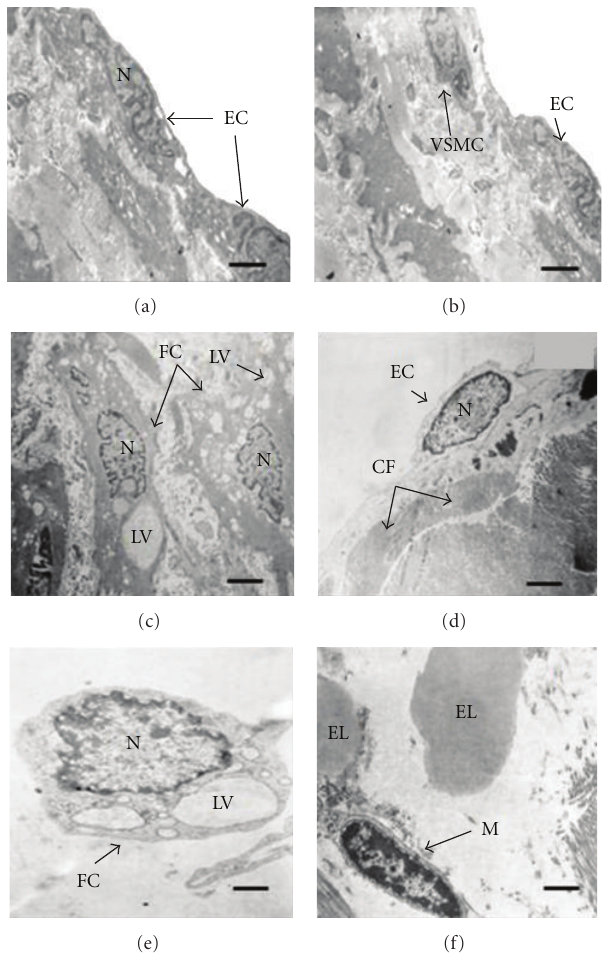
Figure 2: Ultrastructural analysis. Panels (a) and (b) correspond to animals of control group, while panels (b), (c), (d), and (e) show the e ff ects of Lipofundin administration on atherosclerotic lesion formation. EC: endothelial cells, EL: extracellular lipids, VSMC: vascular smooth muscle cells, N: nucleus, FC: foam cells, LV: lipid vacuolization, CF: collagen fibers, M: myofibroblasts. Scale bar 1 μ m (a, b, c, d), 500nm (e, f).